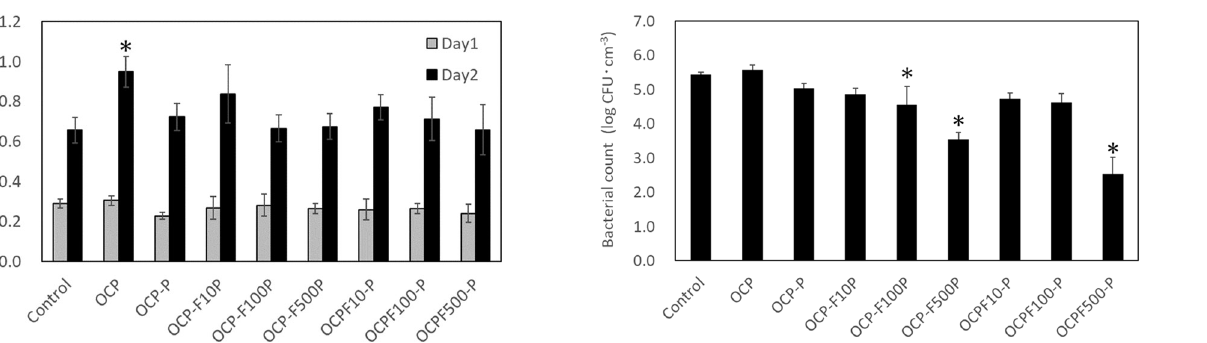
Fig. 7 Proliferation assay of the prepared calcium powders ( n = 4).